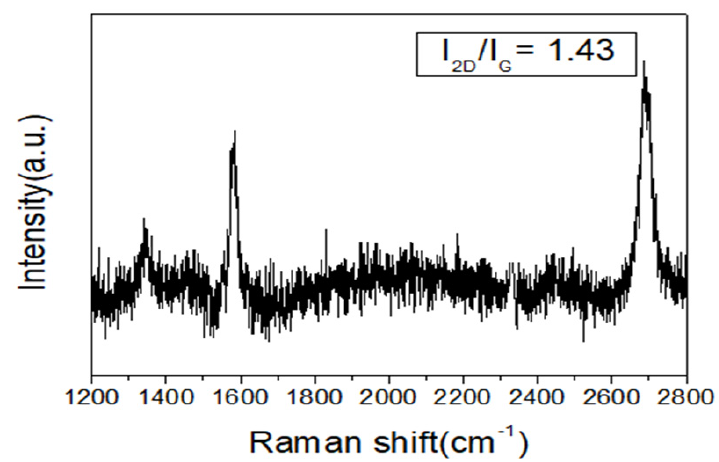
Figure 2. Raman spectrum of graphene on silicon substrate.